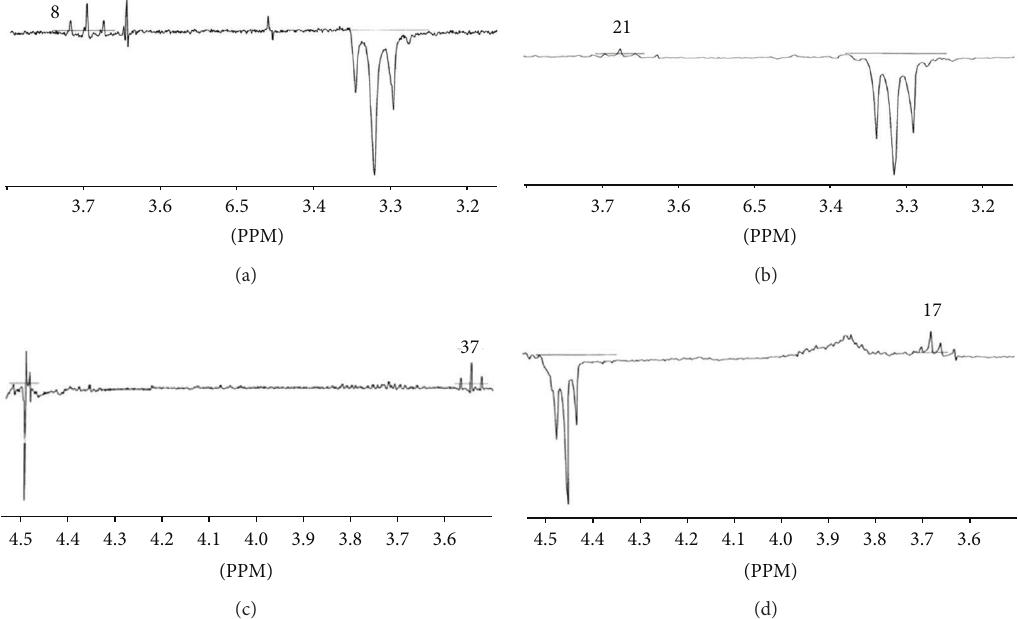
Figure 6: NOE difference spectra of lisinopril in D 2 O/CD 3 CN (9/1, v/v), at 298 K and 300 MHz. Irradiation of H43 and H48 (a, c) major conformer; (b, d) minor conformer. The numbers next to the peaks represent the quantified NOE at